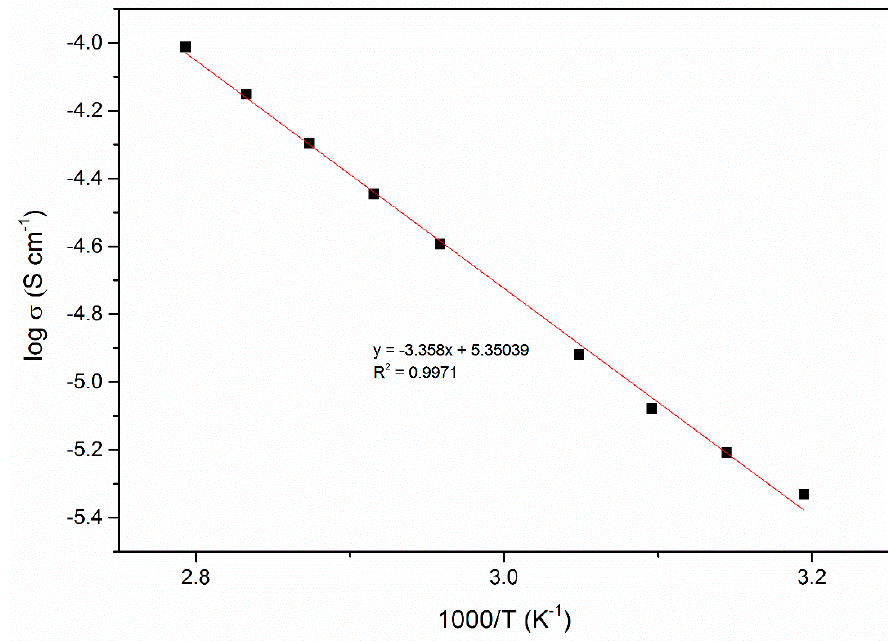
Figure 4. Arrhenius plot of ionic conductivity of PUA/LiClO 4 /EC (9 wt. %) electrolyte.